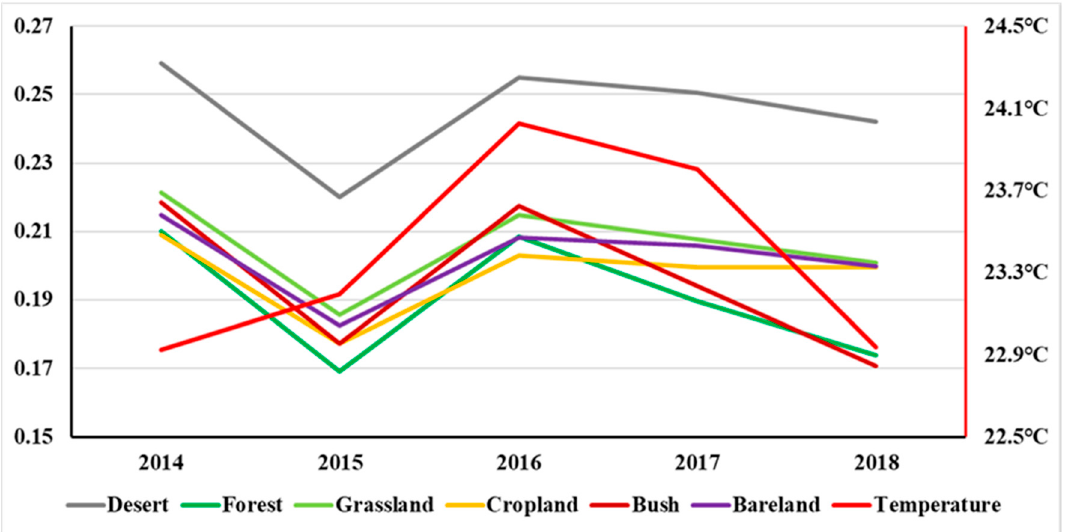
Figure 12. Spatial distribution of Pearson correlation coefficient between annual surface albedo and temperature.